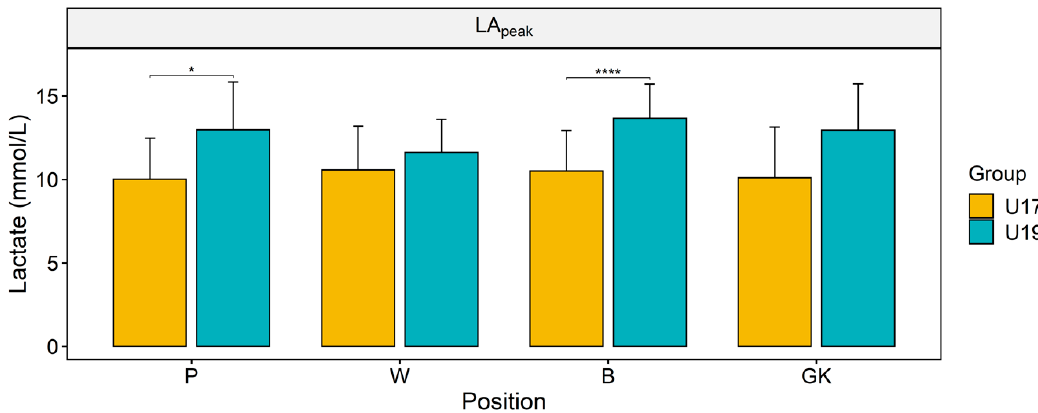
Figure 4. Peak blood lactate [LA] peak concentrations in the participants determined in the endurance